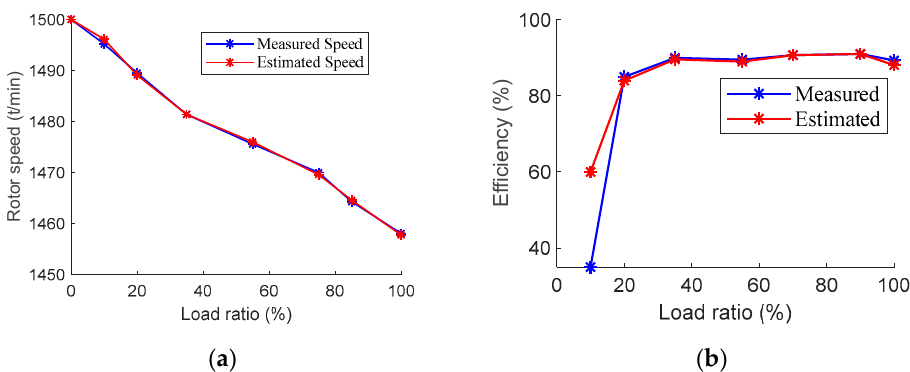
Figure 5. Measured versus estimated: ( a ). estimated versus measured speed according to load ratio; ( b ). estimated versus measured efficiency according to load ratio. Table 3. Comparison of determined parameters of 5.5 kW motor.